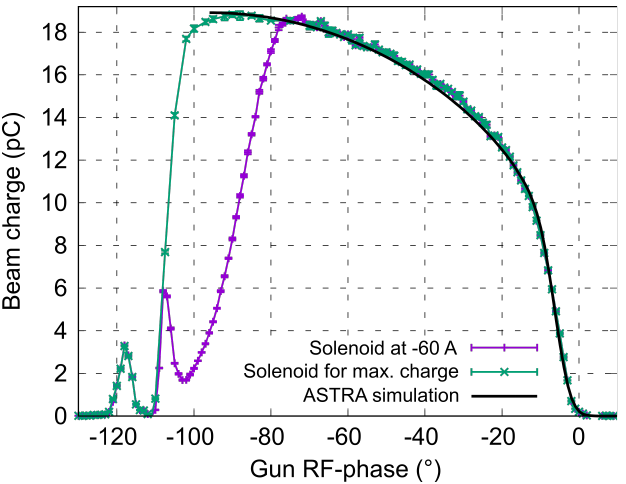
Figure 6. Bunch charge measurement during an RF phase scan (Schottky scan). Purple colored measurement data were achieved at a constant solenoid current of − 60A. The solenoid current was optimized for a maximum charge at the DaMon for the green curve. A fit with an ASTRA (A Space Charge Tracking Algorithm) simulation allows the duration of bunch emission to be estimated